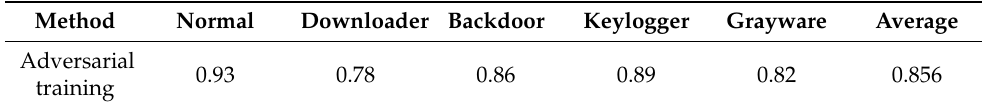
Table 4. Effect of BERT-TextCNN joining adversarial